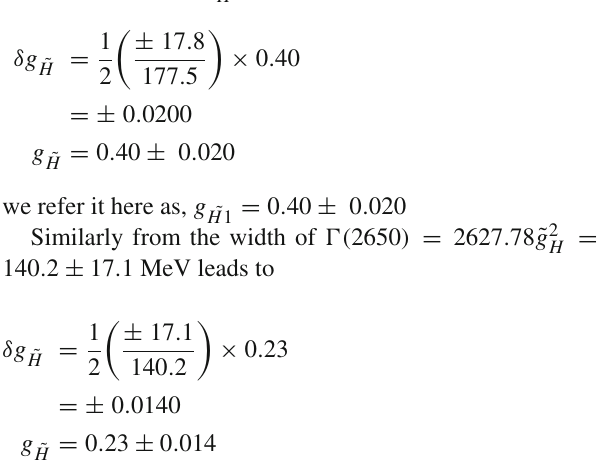
Table18 Valueofvariouscouplingconstantsobtainedfromthepresent study compared with other values available in the